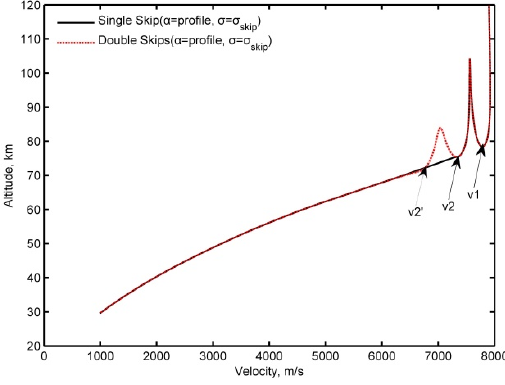
Figure 6. Skips and baseline trajectory combination.